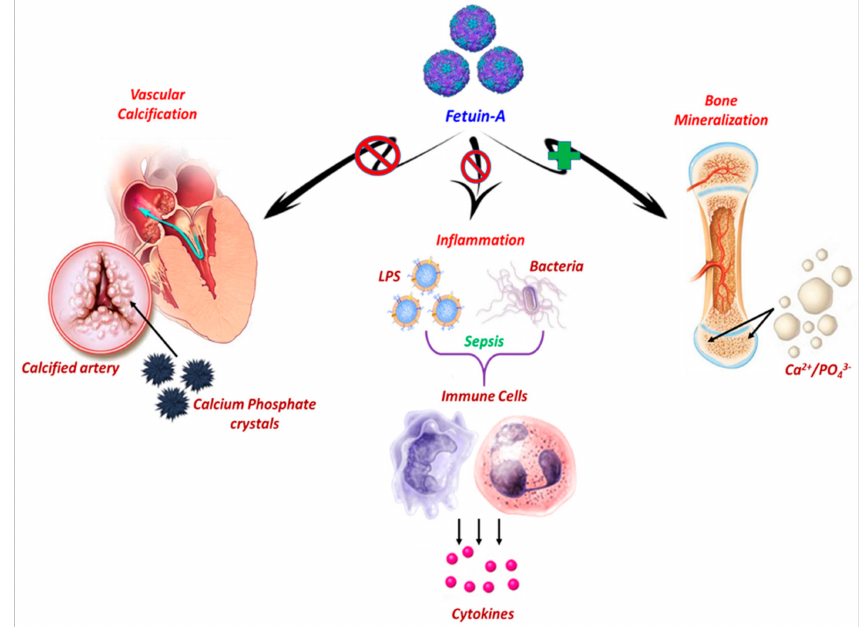
Figure 1. Graphical representation of main physiological roles of hepatic-secreted Fetuin-A. Under physiological conditions, Fetuin-A (Fet-A) enhances the absorption and fixation of essential minerals, calcium, and phosphate in the form of hydroxyapatite substituted with a carbonate. Moreover, Fet-A acts as a carrier of insoluble phosphate and calcium, and forms stable mineral complexes, more soluble in the bloodstream, preventing the precipitation of calcium salts through the mediation of their clearance, and the consequent occurrence of vascular calcifications. Fet-A functions as a negative regulator of the innate immune response by inhibiting Lipopolysaccharide (LPS)- or Interferon (IFN)- γ -induced High mobility group box 1 protein (HMGB1) release in macrophages in response to lethal endotoxemia or